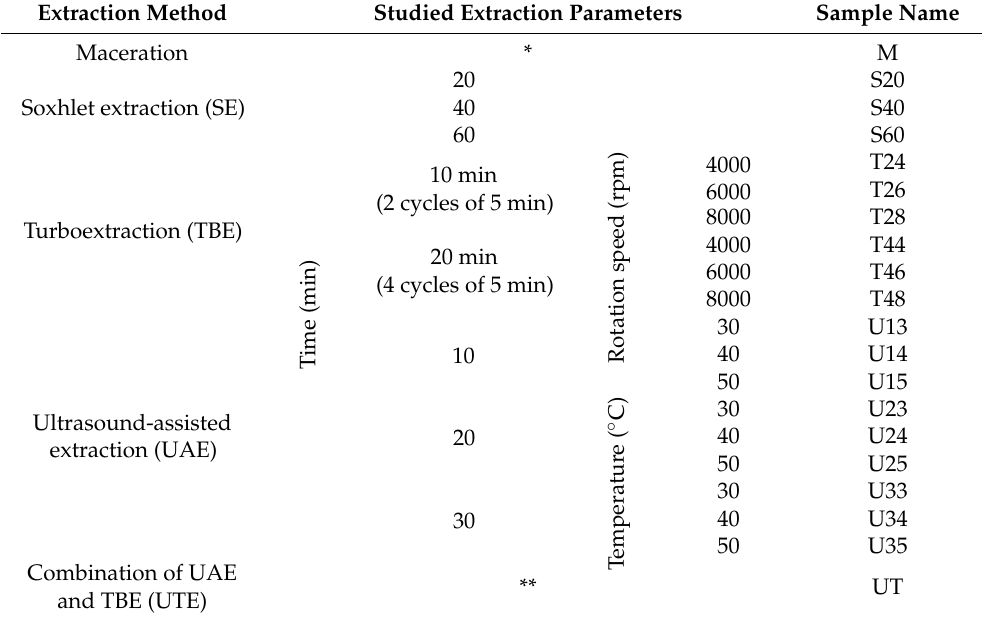
Table 1. Nomenclature of the evaluated green coffee bean